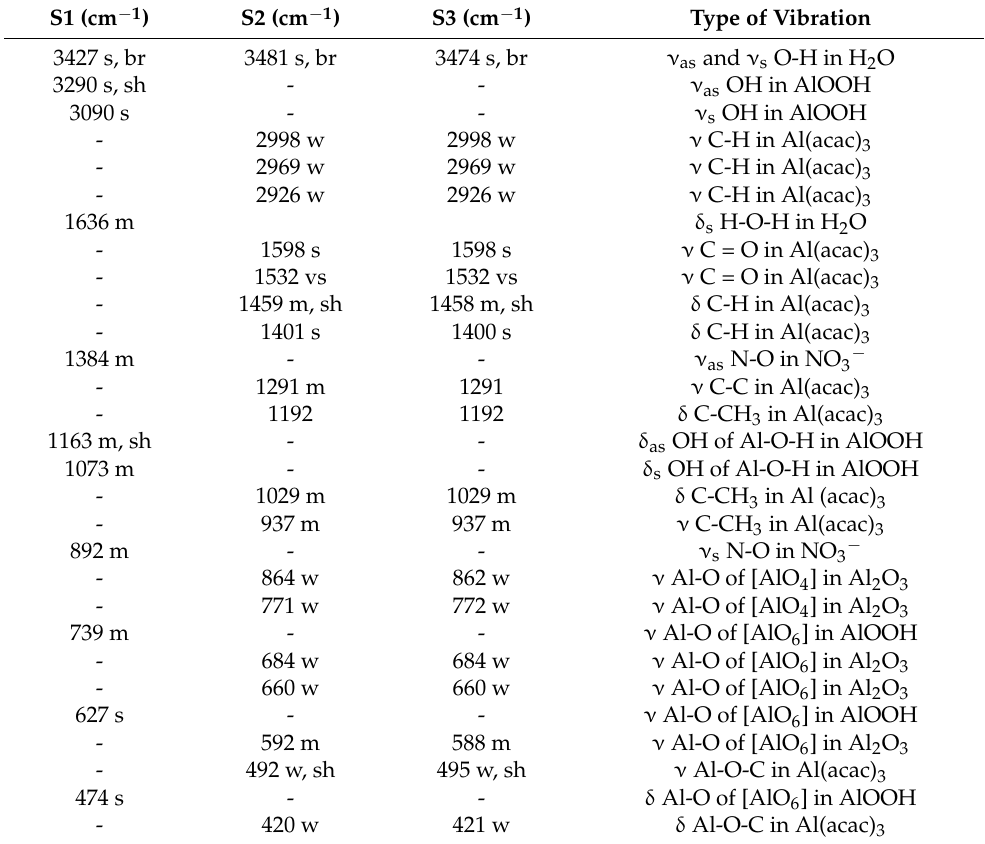
Table 2. Positions and assignments of the bands from FTIR reflectance spectra of samples S1, S2, S3 in room